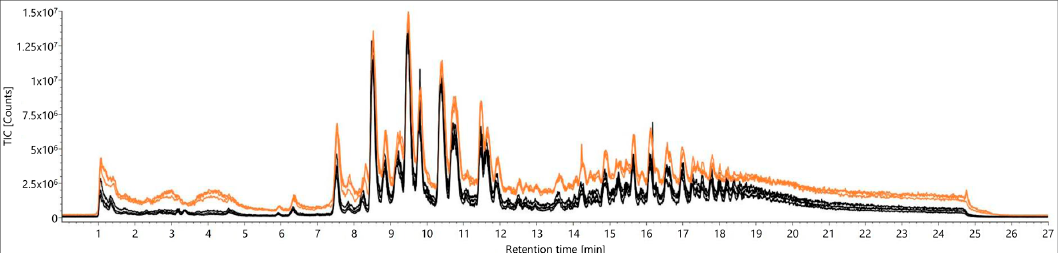
Figure 3. Comparison of total ion chromatograms (TICs) from a quality control (QC) sample according to Folch [23] for signal stability over five days: first five injections (orange) versus the last five (injections 240–260, black).